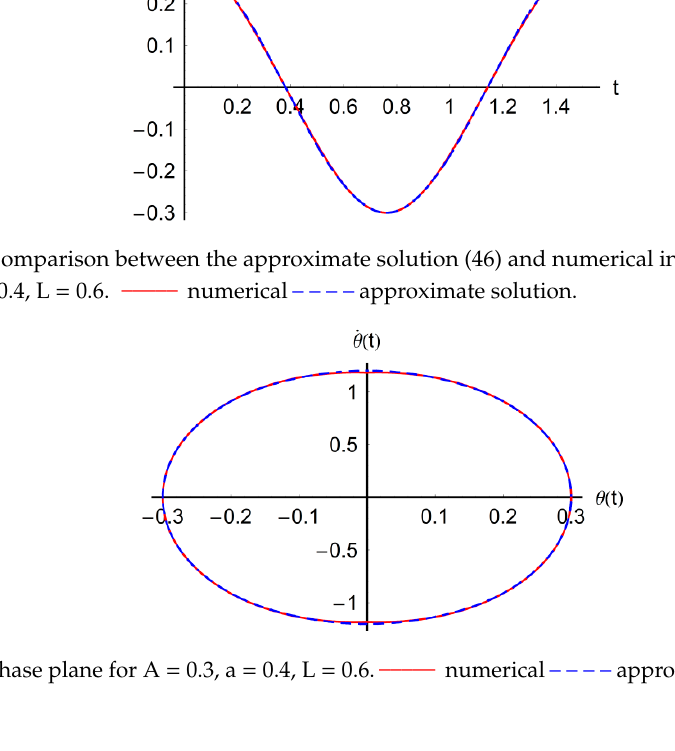
approximate solution (50).